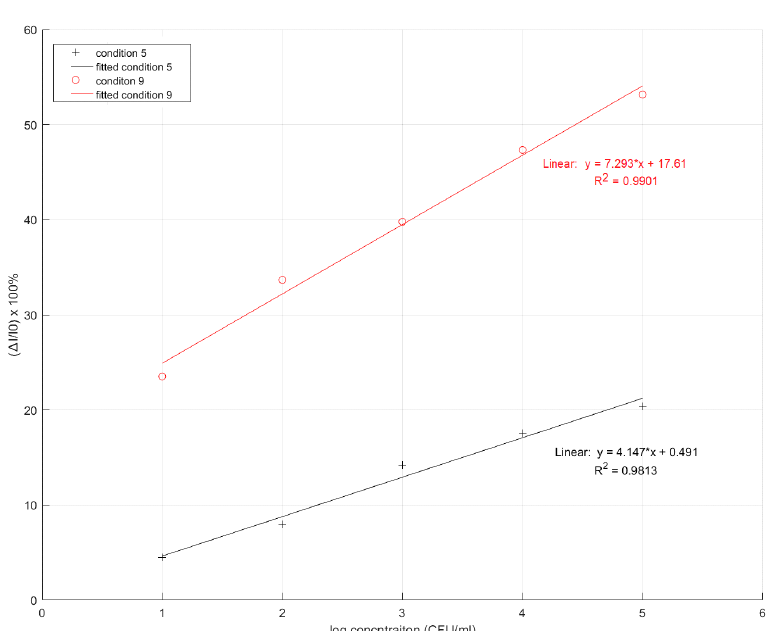
Figure 5 . ( a ) Cyclic voltammogram of K. pneumoniae at concentration levels in condition 5 on gold electrode; ( b ) cyclic voltammogram of K. pneumoniae at concentration levels in condition 9 on gold electrode.